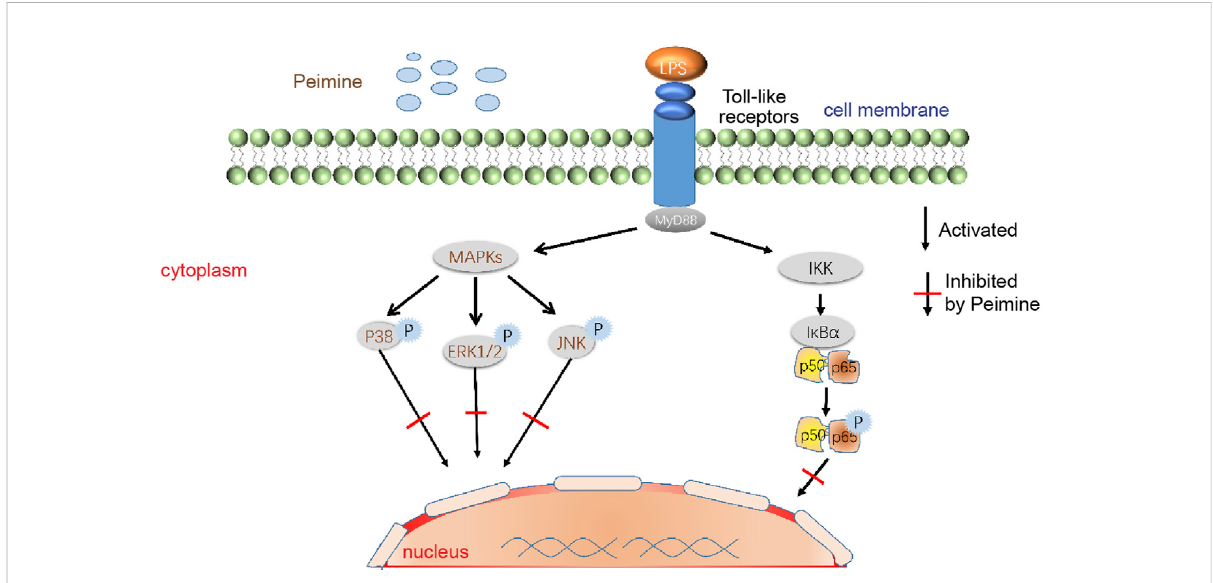
FIGURE 5 Modulationof MAPK and NF- κ B signaling pathways by peimine. Abbreviations: LPS, lipopolysaccharide; IKK, inhibitor of nuclear factor kappa-B kinase; P, phosphorylation; MAPKs, mitogen-activated protein kinases; MyD88, myeloid differentiation factor 88; NF- κ B, nuclear factor kappa-B; ERK, extracellular signal-regulated kinase; JNK, c-Jun N-terminal kinase. I κ B α are signi fi cant members of the I κ B (NF- κ B inhibitor) clan, while NF- κ B p50 and p65 are the most delegated dimer complexes in the nuclear transcription